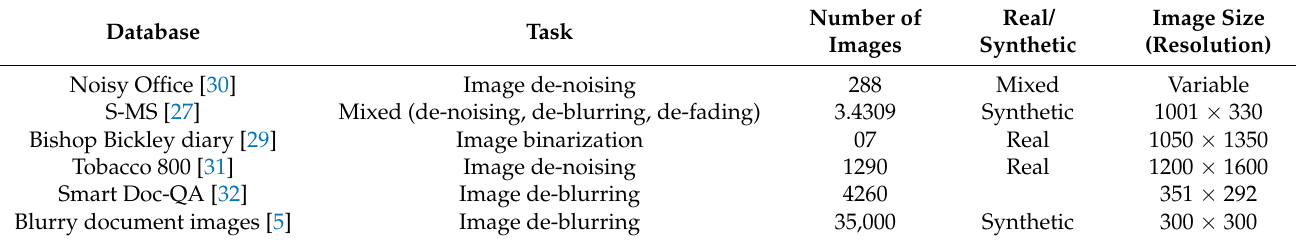
Table 1. Datasets used for image enhancement